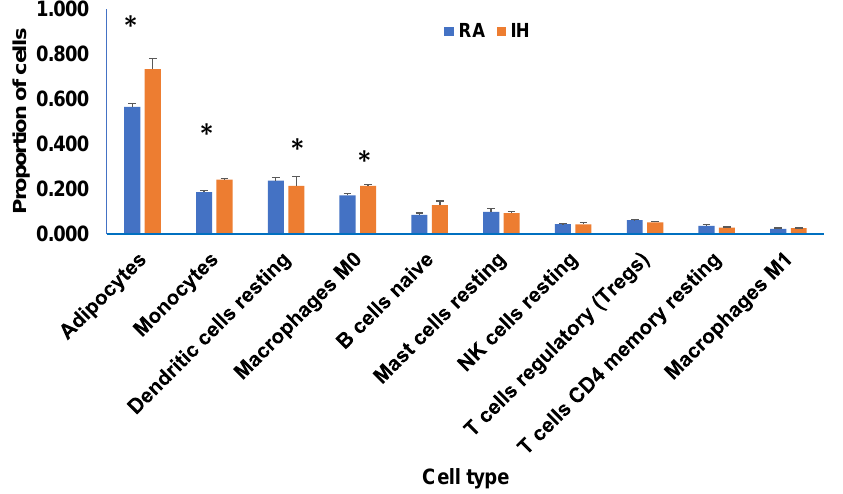
Figure 8. Deconvolution of bulk RNA-Seq of vWAT in mice exposed to IH compared to RA for 6 weeks. Bar graphs depict the frequency of each cell type in each condition from bulk RNA-seq data, as proportions of total cells inferred from markers of adipocytes; monocytes; dendritic cells resting; macrophages (M0); B cells; naïve; mast cells resting; NK cells resting; T cells regulatory (Tregs); T cells CD4; memory resting; and macrophages M1. Y -axis indicates the estimation of cell subtype proportion fraction of each cell type, X -axis indicates cell types. A comparison of decomposition estimates 547 genes from mouse immune system and 712 of mouse adipocytes as described in the